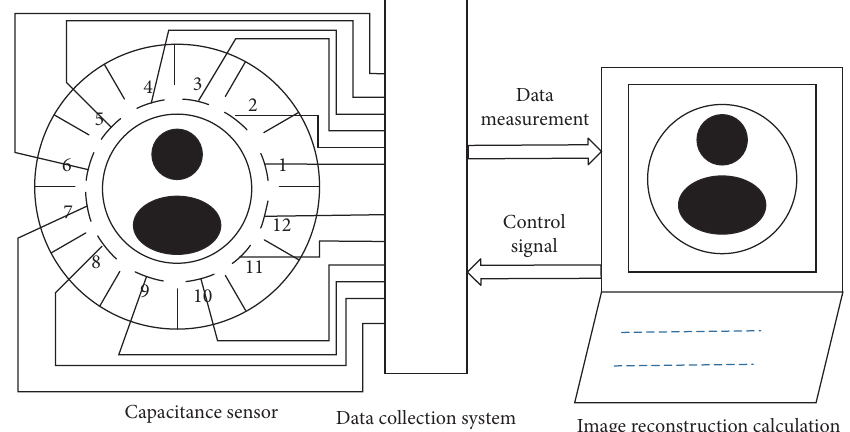
Figure 1: Structure of 12-electrode ECT